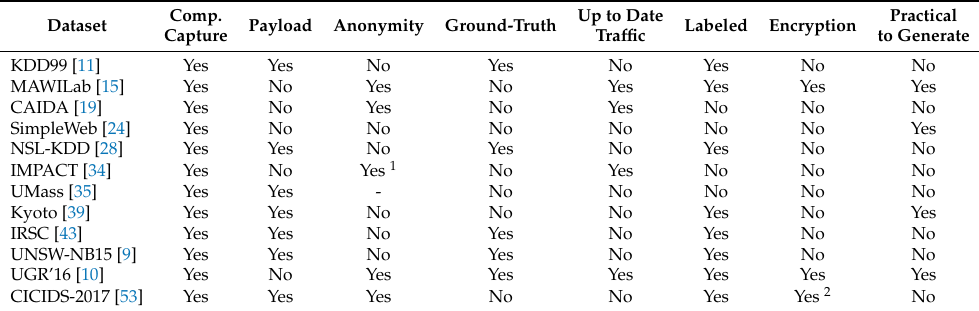
Table 1. Comparison of IDS datasets based on the requirements in Section